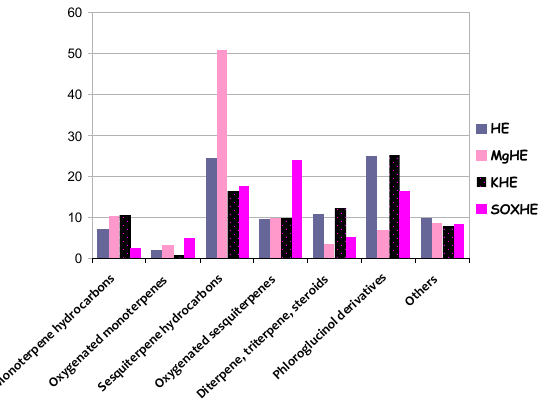
Figure 5: Comparative representation of particular groups of compounds (monoterpene hydrocarbons, oxygenated monoterpenes, sesquiterpene hydrocarbons, oxygenated sesquiterpene, diterpenes, triterpenes and steroids, phloroglucinol derivatives and other compounds) in the investigated